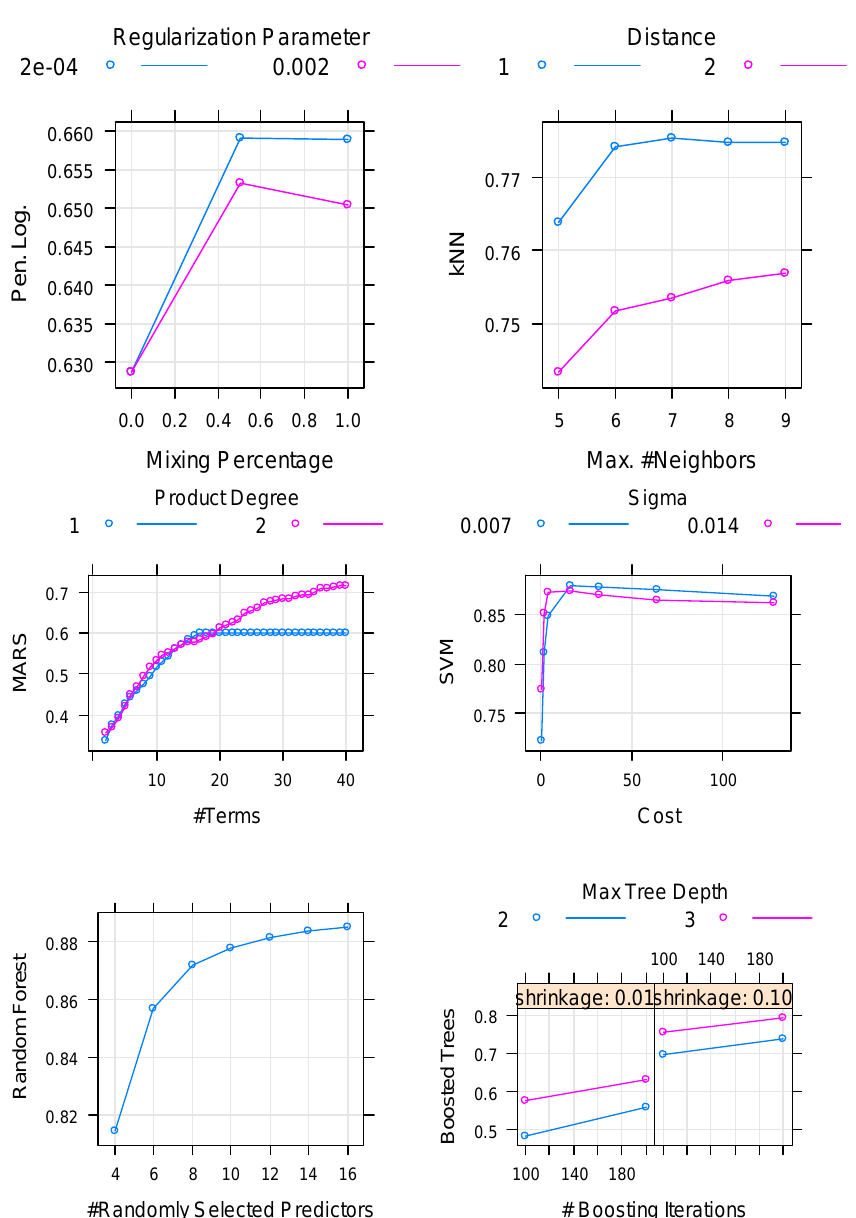
Figure 3. Tuning process. The y-axis measures the accuracy (percentage of correct classifications) and the x-axis measures the tuning parameters of the corresponding algorithm .